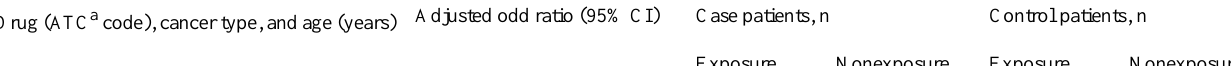
Table 3. Associations between different drugs and cancers among different age